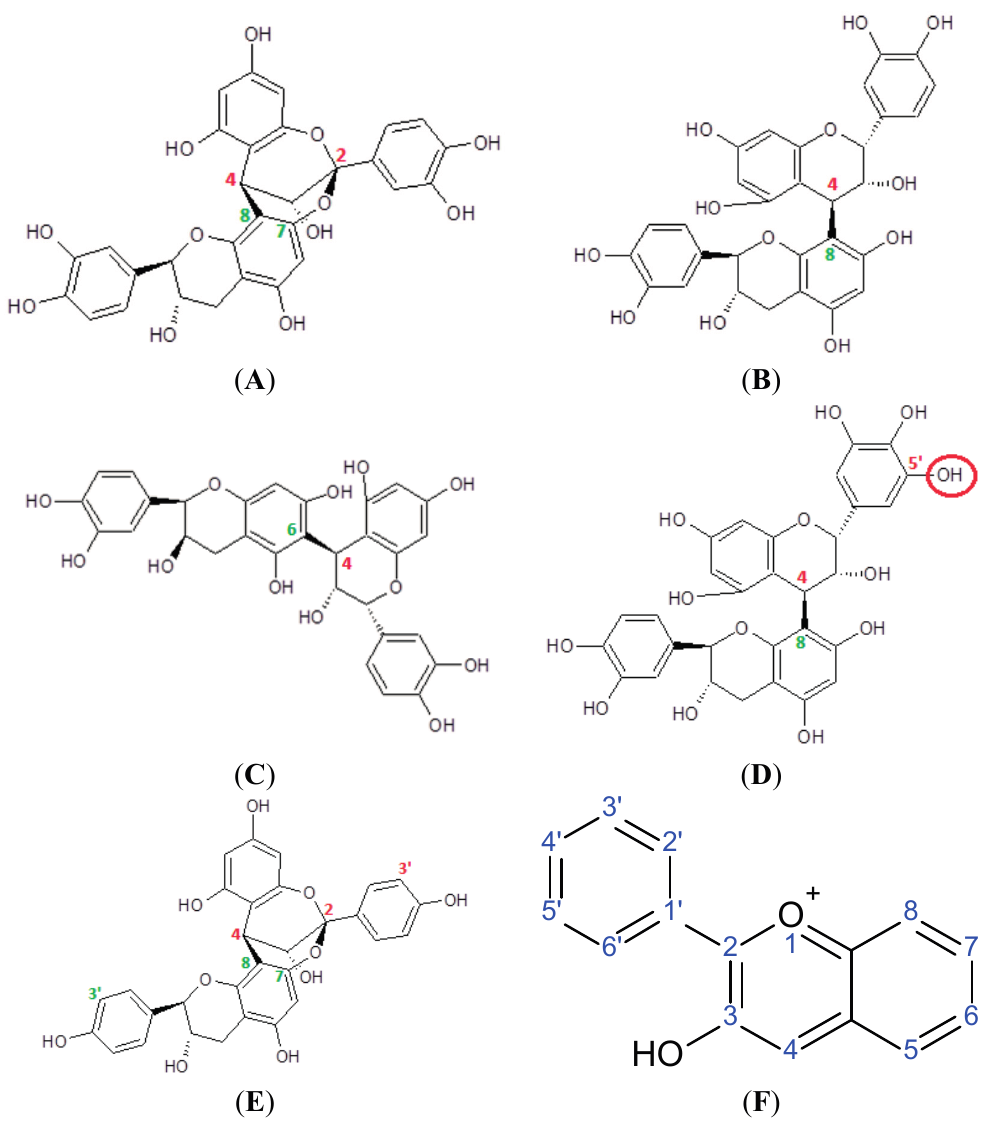
Figure 3. ( A ) Dimeric A type procyanidin (epicatechin-catechin dimer) with C-4 → C-8 linkage and C-2 → O → C-7 ether bond. Red numbering: epicatechin moiety; green: catechin moiety; ( B ) dimeric B type procyanidin (epicatechin-catechin) with C-4 → C-8 linkage. Red: epicatechin moiety; green: catechin moiety; ( C ) dimeric B type procyanidin (epicatechin- epicatechin) with C-4 → C-6 linkage; ( D ) dimeric B type prodelphinidin (EGC-catechin) with C-4 → C-8 linkage. Red: EGC; green: catechin. Additional OH group at 5 ′ is marked; ( E ) dimeric A type propelargonidin (epiafzelechin-afzelechin) with C-4 → C-8 and C-2 → O → C-7 bonds. Red: epiafzelechin; green: afzelechin. Note the lack of OH groups at the both 3 ′ positions; ( F ) general structural formula of